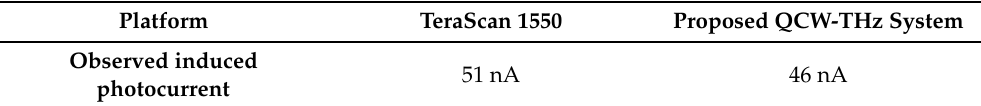
Table 2. Comparison between the observed photocurrent at detector PCA using the off-the-shelf CW-THz system and the proposed system at the same target frequency f = 289.33 GHz.